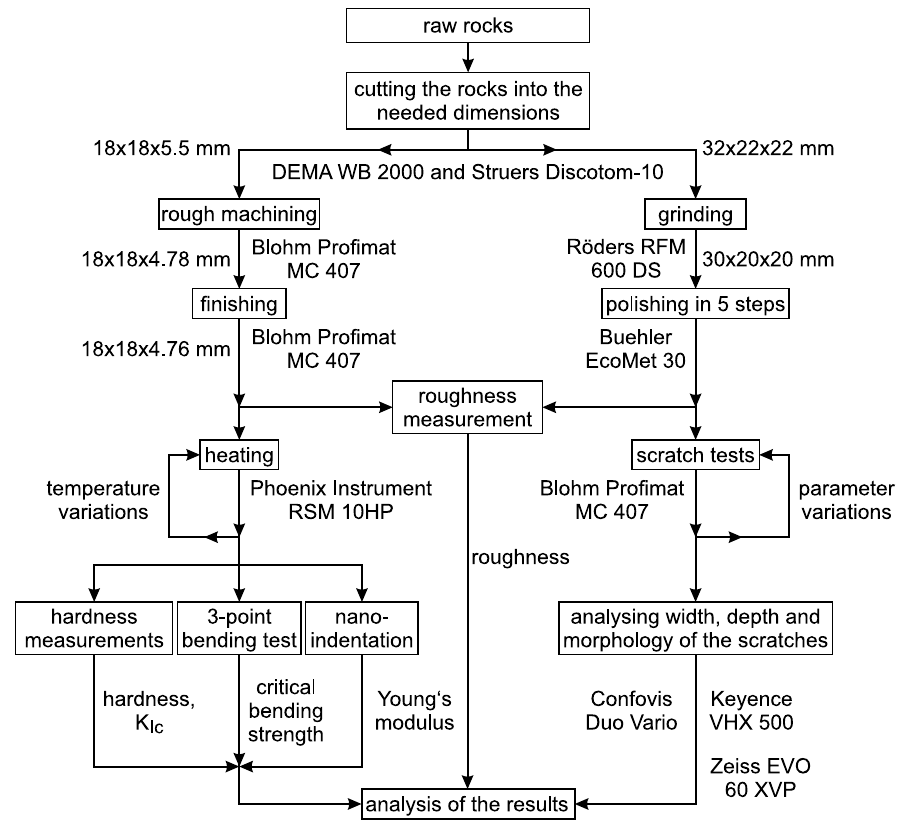
Fig. 2 Flow chart of the proce- dure of the experiments